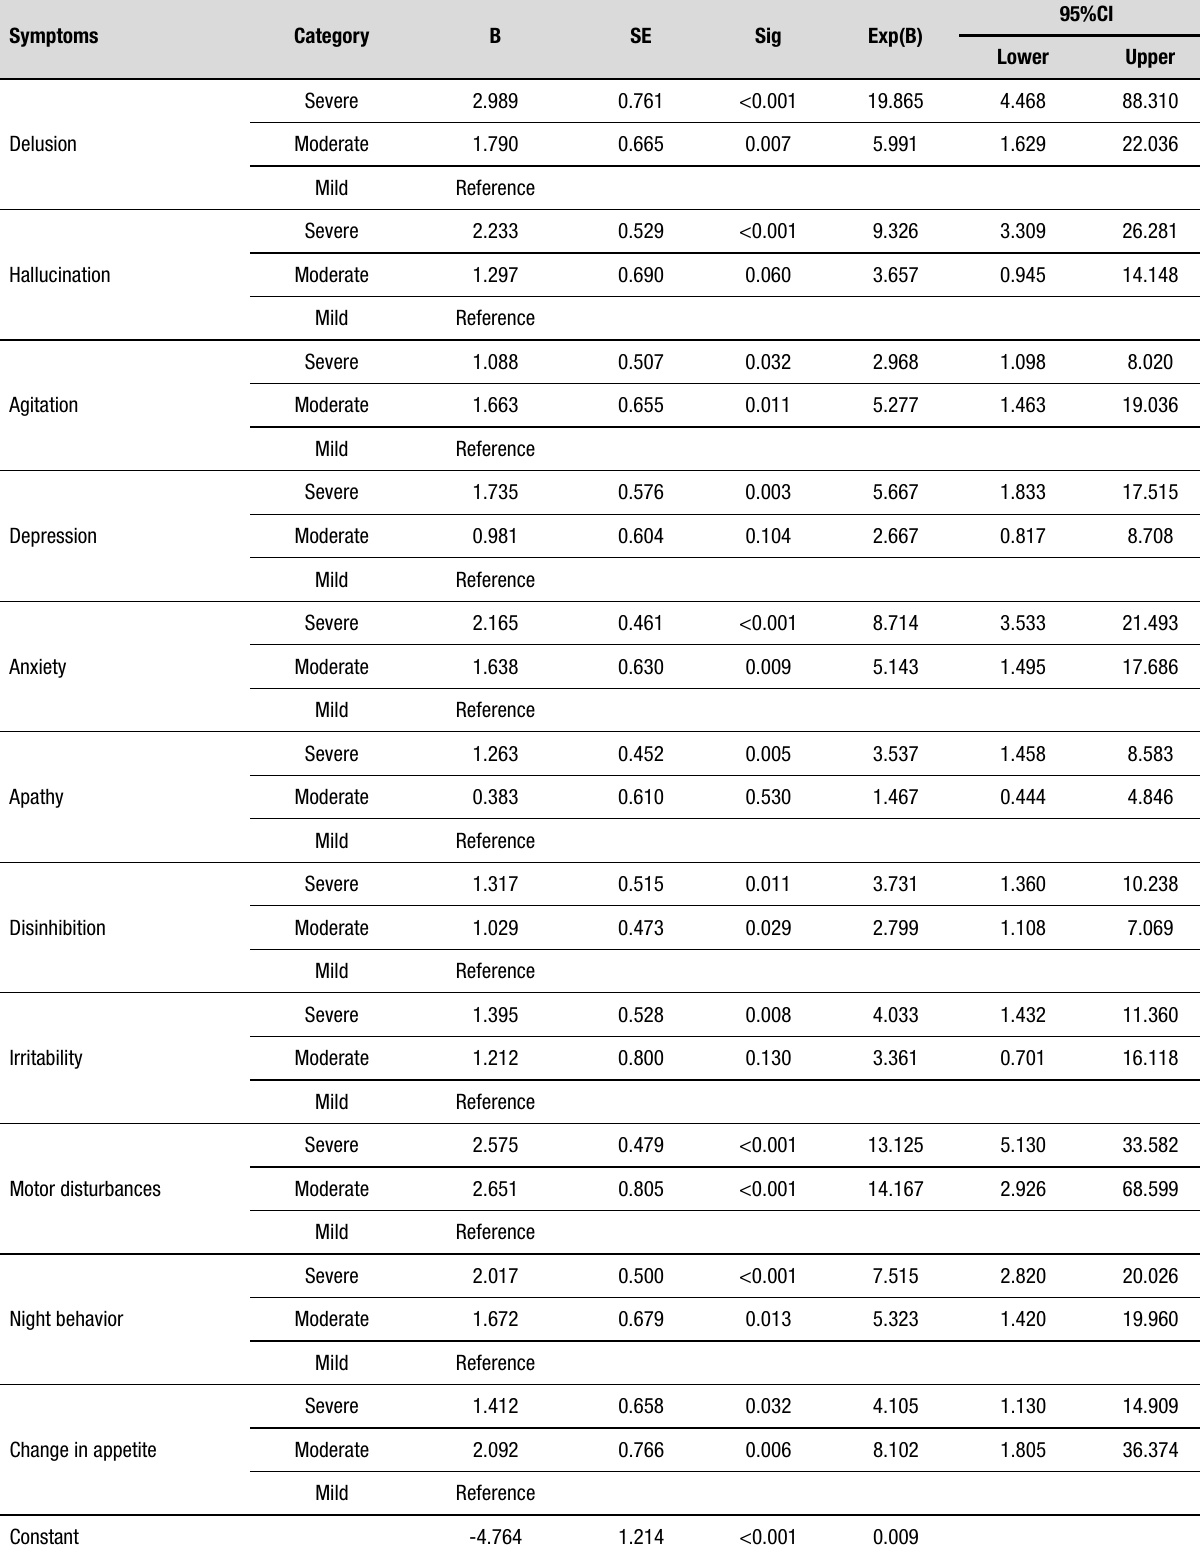
Table 3. Result of binary logistic regression analysis between care-recipients’ neuropsychiatric symptoms and caregivers’ level of